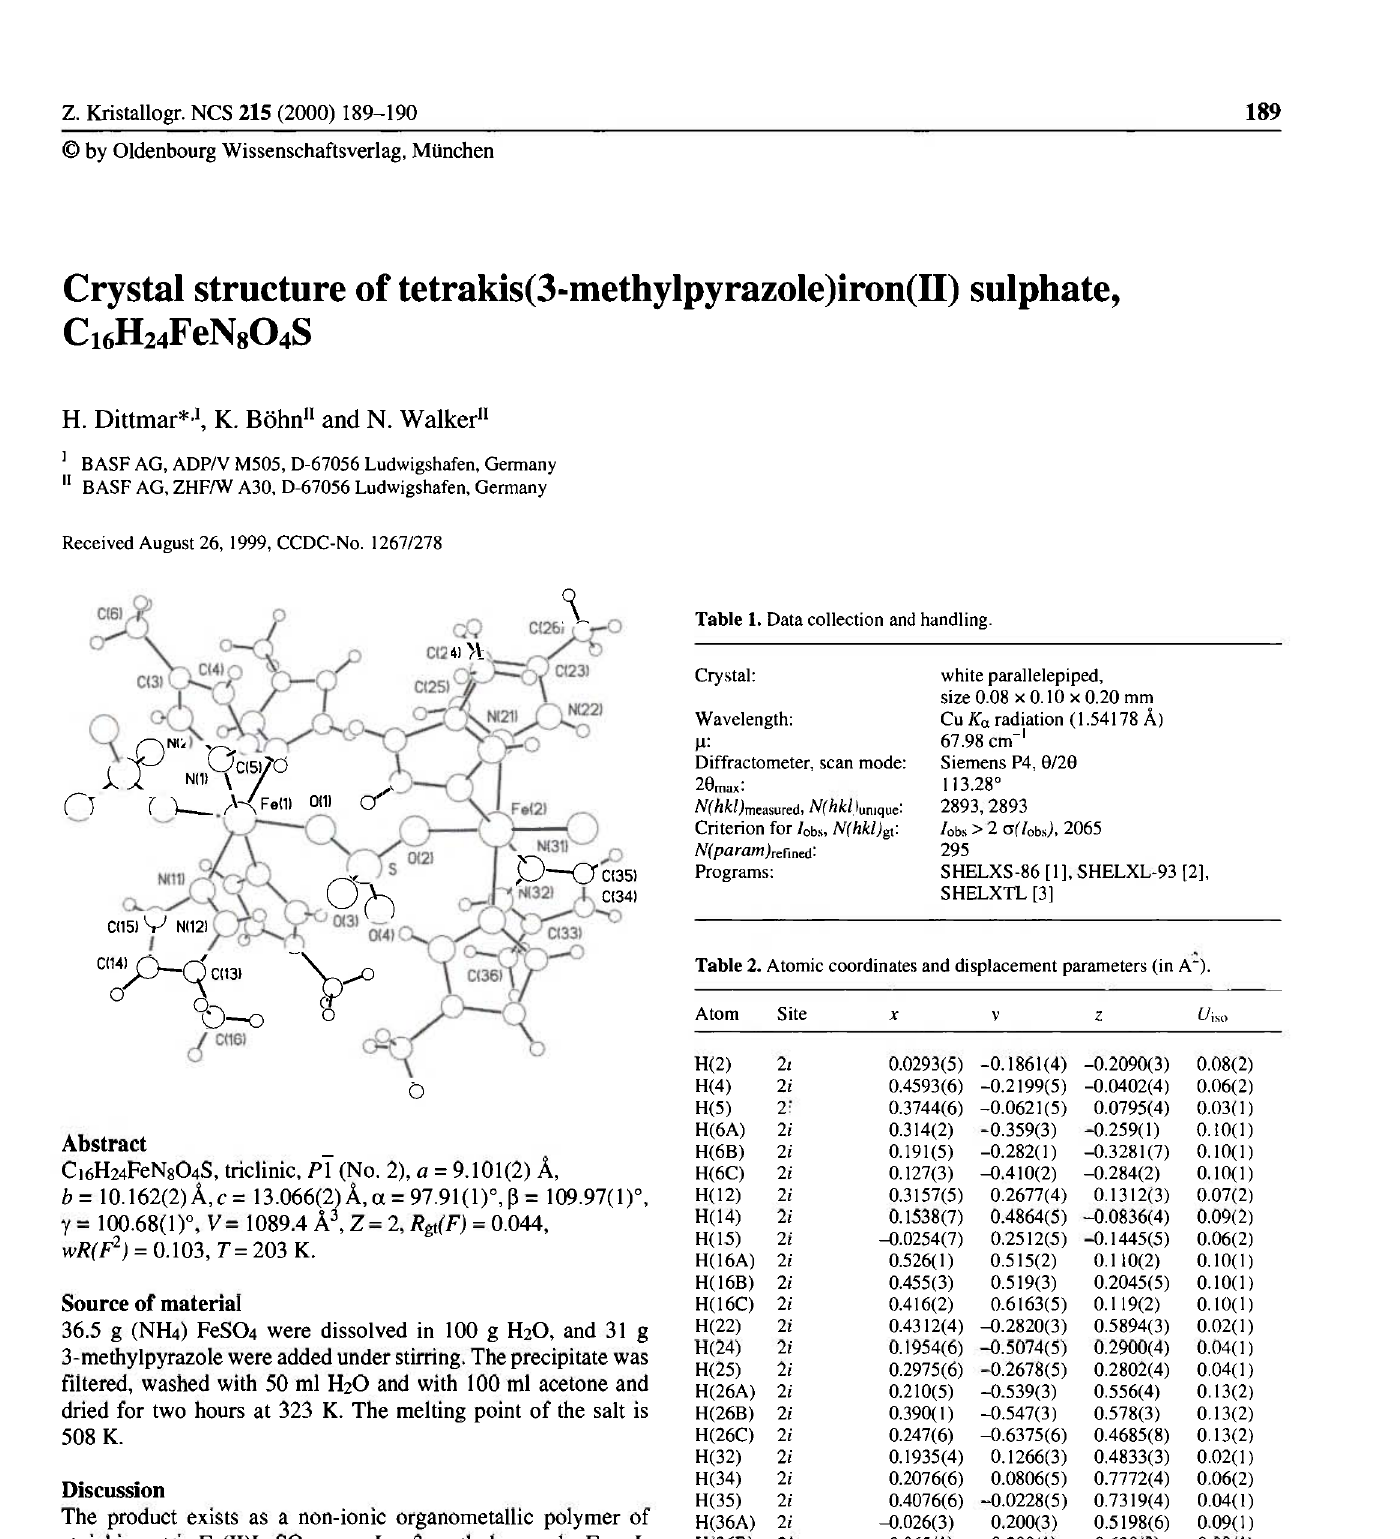
Table 2. Atomic coordinates and displacement parameters (in